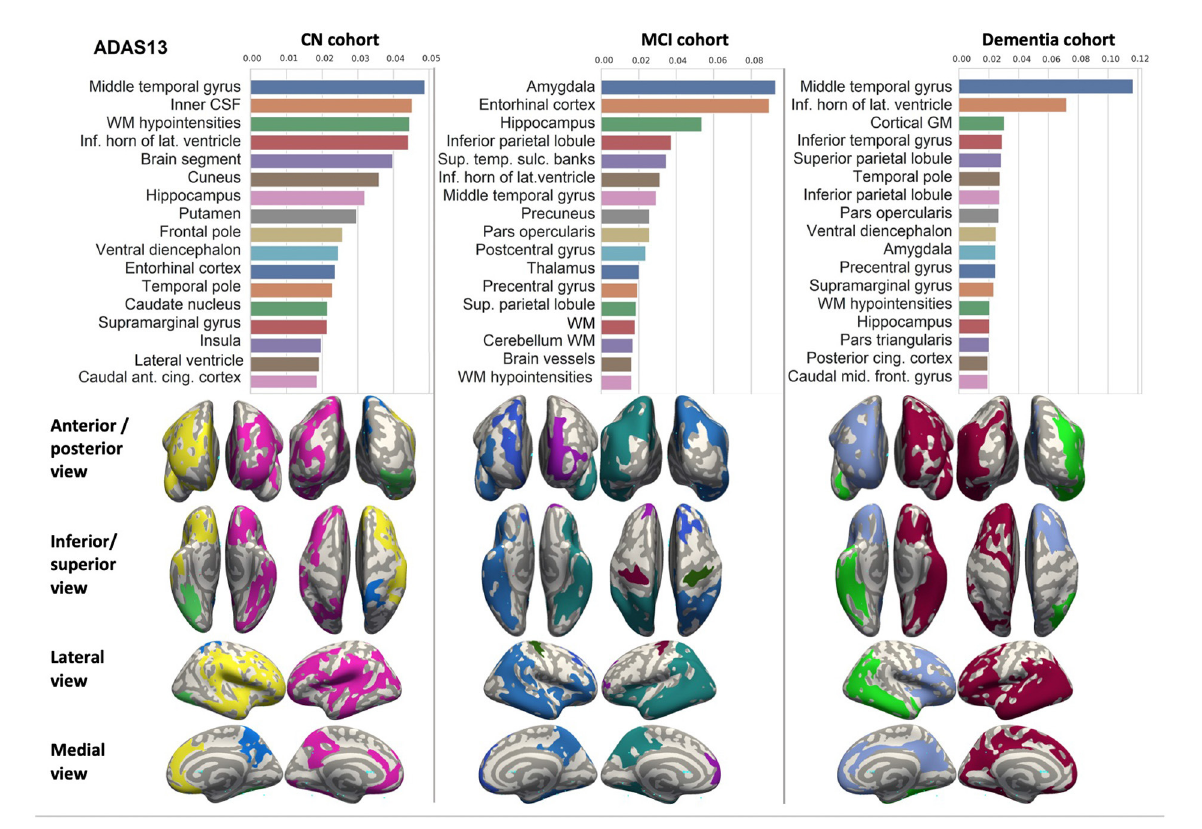
FIGURE4 Brain structures ranked according to information gain value for ADAS13 score prediction. Inflated cortical representations showing significant correlations between cortical volumes and test